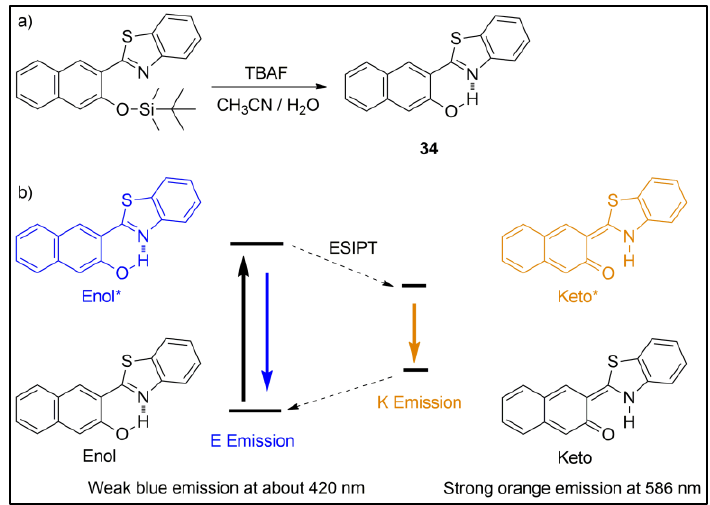
Figure 34. ( A ) Chemical structure of 34 with the equilibrium between protonated and unprotonated species and ( B ) ESIPT process of 34 in the presence of F −. [109].